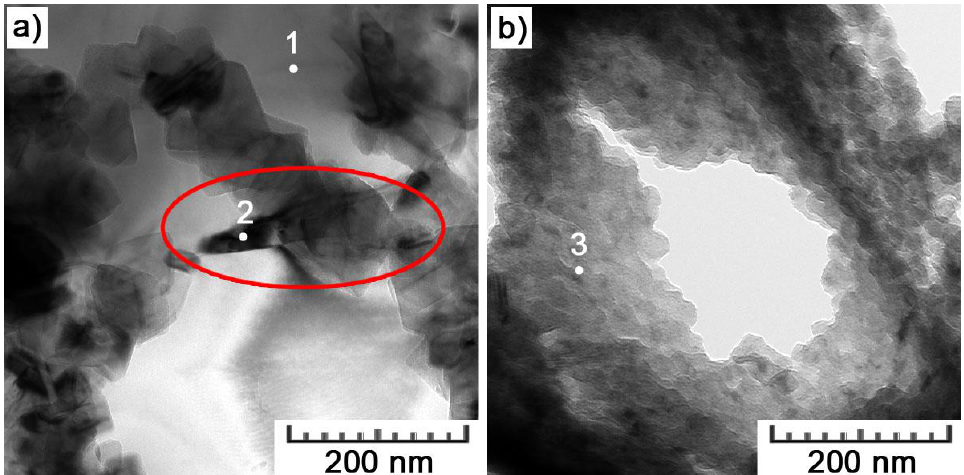
Figure 9. Diffraction pattern and its evaluation. Materials 2018 , 11 , x FOR PEER REVIEW 10 of 17